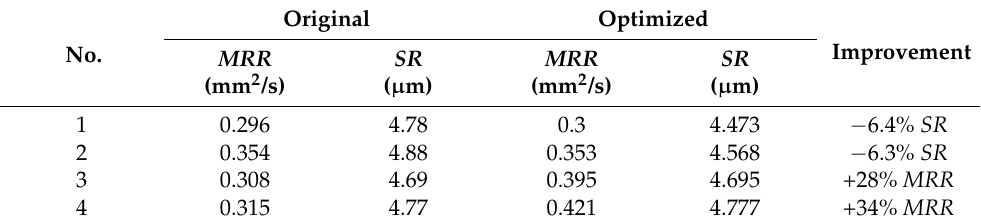
Table 8. The comparative results of MRR and SR under optimized and original process parameters.